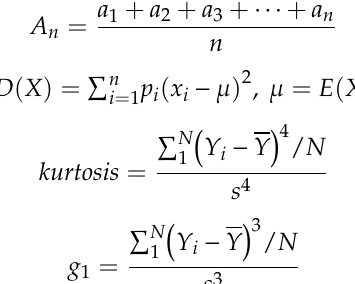
Table 1. The format of features extracted.